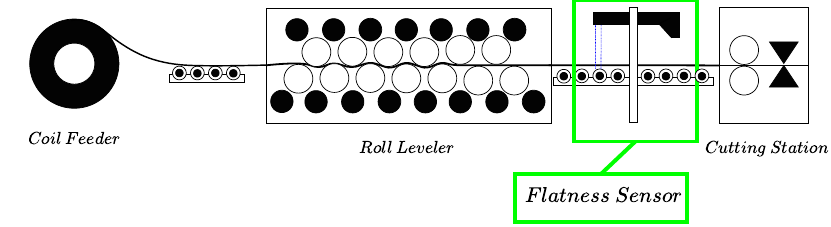
Figure 4. A simplified block diagram showing an industrial finishing line. The flatness sensor lies between the roll leveler and the cutting